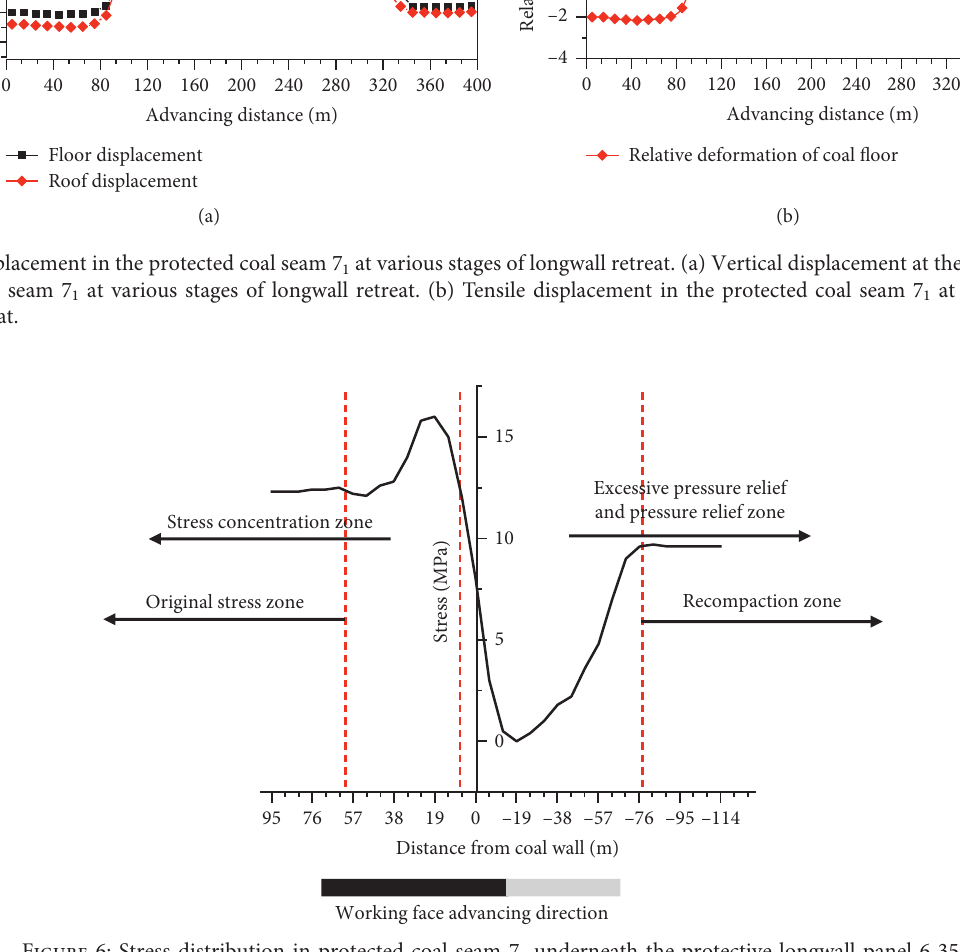
1 underneath the protective longwall panel 6 1 35.